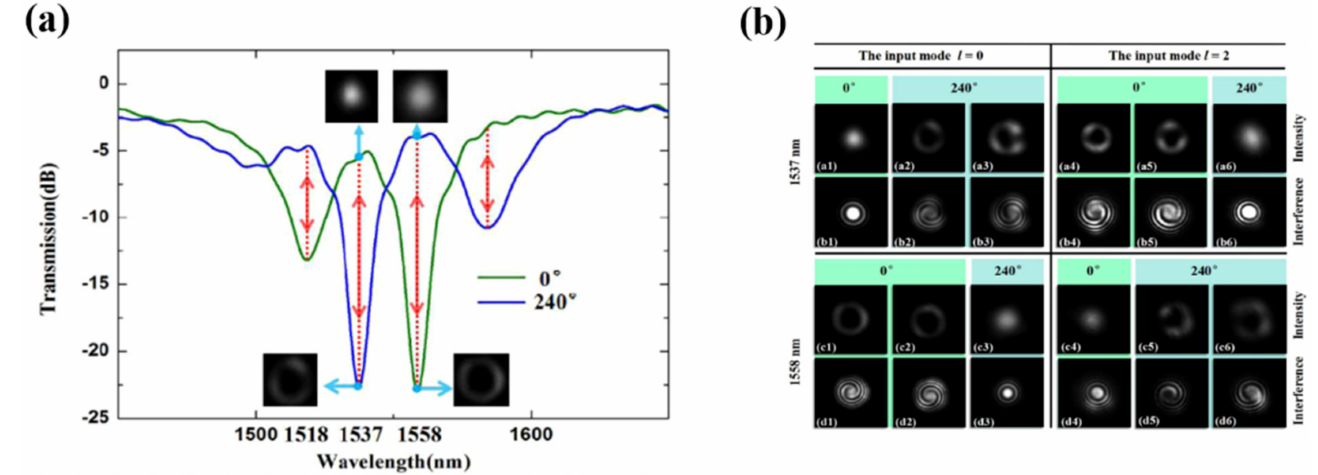
Figure 30. ( a ) Changes of the resonant mode at different wavelength under two different torsions. ( b ) Intensity and phase distributions of output modes. Adapted with permission from ref. [173]. © The Optical